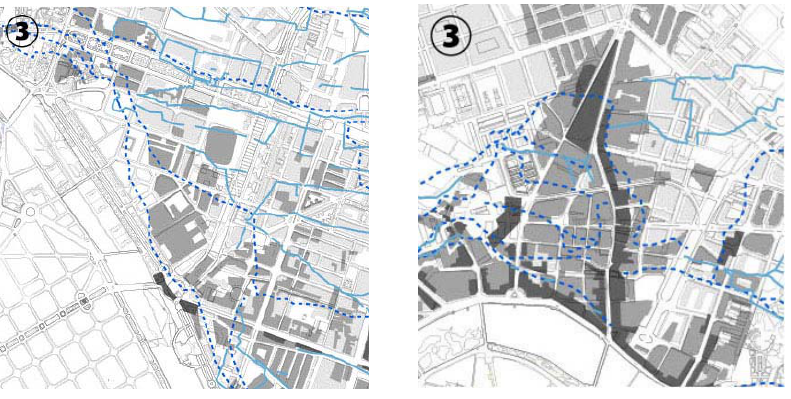
Figure 7. In the areas labeled ③, the canals disappeared during the period between 1883 and 1946.